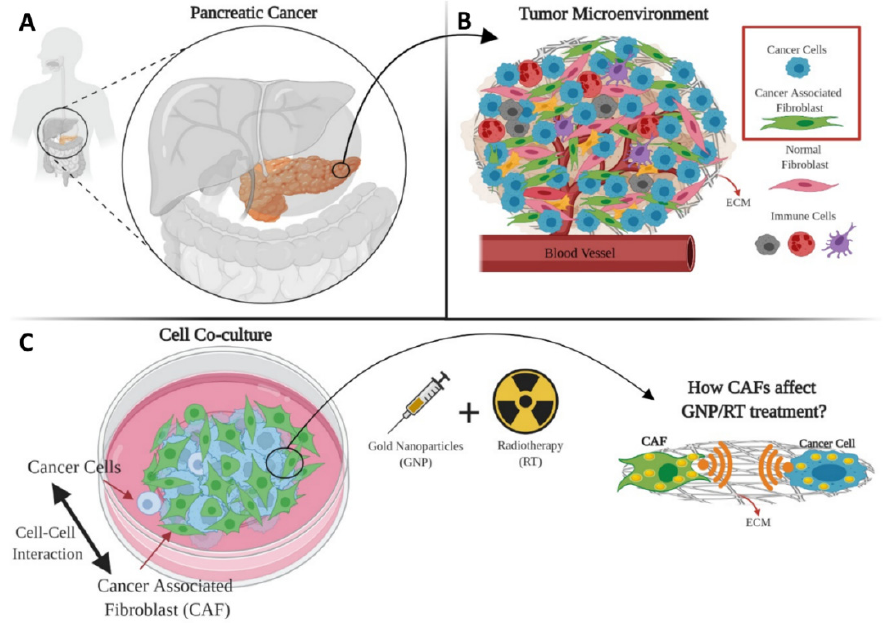
Figure 1. Schematic showing the complexity of the pancreatic cancer tumour microenvironment (TME) and possible targeting using gold nanoparticles (GNPs) as radiosensitizers. ( A ) Pancreatic cancer location in the proximity of many vital organs. ( B ) Two of the most important components of the TME are cancer cells and cancer-associated fibroblasts (CAFs) which coexist in co-culture. ( C ) Cancer cells and CAFs were grown together in co-culture for cell-to-cell interaction to occur.